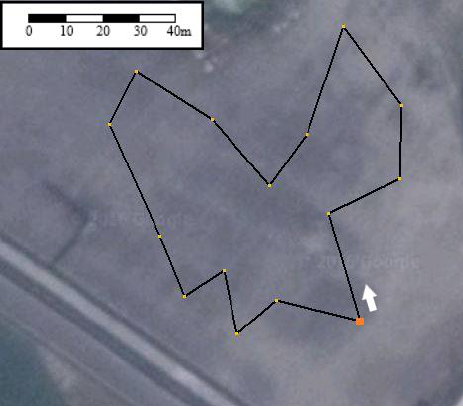
Figure 10. Shortest Single Distance Path.